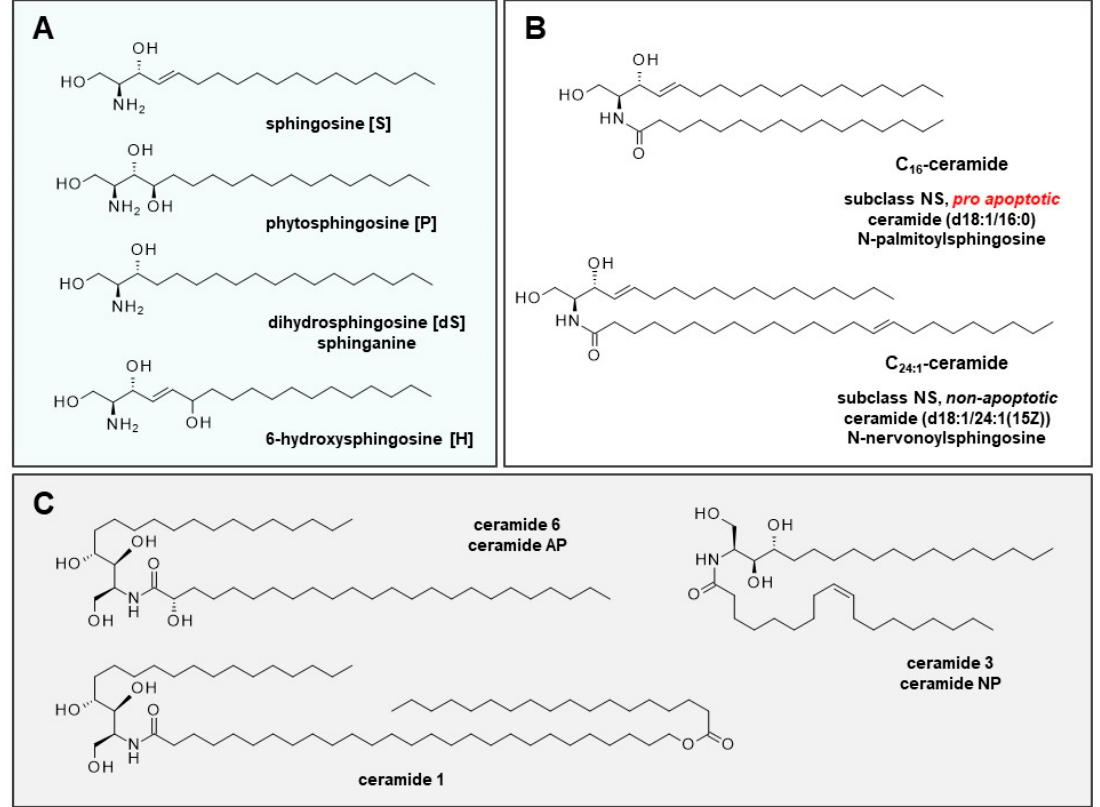
Figure 1. Backbones of dermal ceramides, cell cycle-relevant ceramides, and ceramides in basic